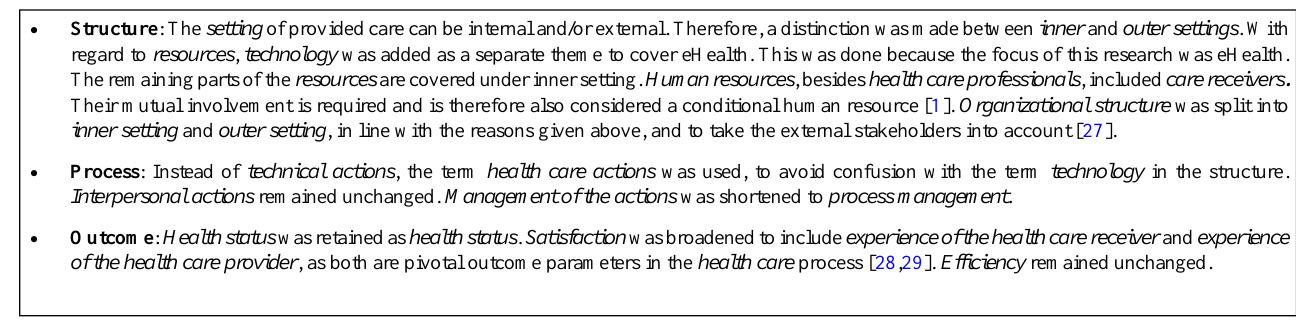
The Donabedian SPO framework was designed in the 20th time and incorporated the application of eHealth. The